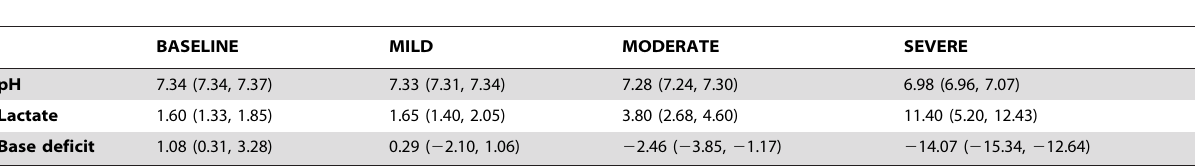
Table 2. Median values of pH, lactate and base deficit according to protocol phases.